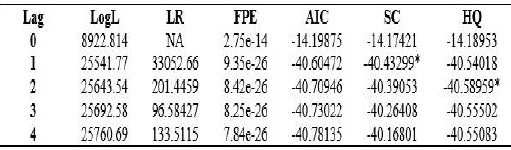
Table 4: Determining the Optimal Lag Length